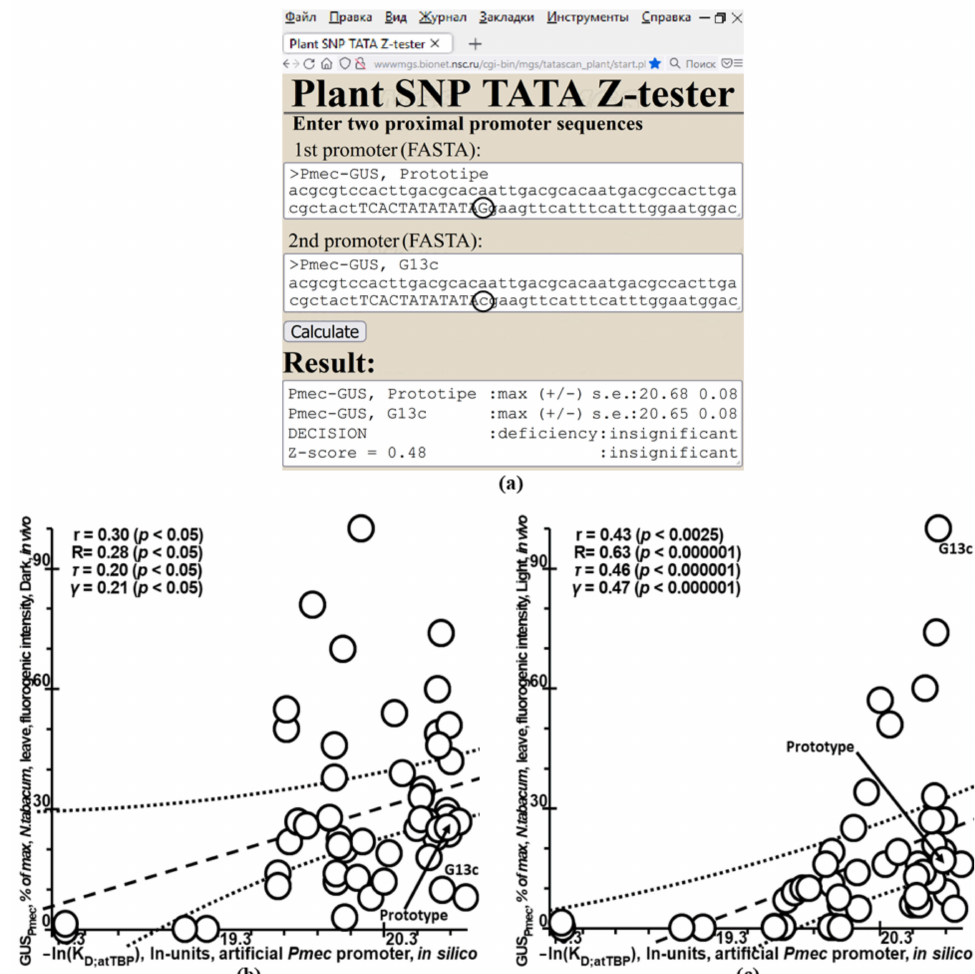
Figure 3. Determining the application limits of Plant_SNP_TATA_Z-tester on experimental data about tobacco development in the dark or under light [53], which indicated that the inverse problem under study is ill-posed. Legend : see the legend of Figure 1. ( a ) The result of our Web service Plant_SNP_TATA_Z-tester created in this work in the case of the comparison between the prototype Pmec of the artificial promoter for plant genes (the textbox “1st promoter”) and its mutant variant “G13c” (the textbox “2nd promoter”). ( b , c ) Statistically significant correlations between the in silico predicted − ln(K D ) values of TBP–promoter affinity expressed in ln units, which characterize the complexes formed by tobacco TBP binding to various artificial promoters based on the Pmec prototype [59] ( x -axis) and the in vivo efficiency magnitudes of the reporter gene gusA expression ( y -axis) on tobacco development in the dark or under light,